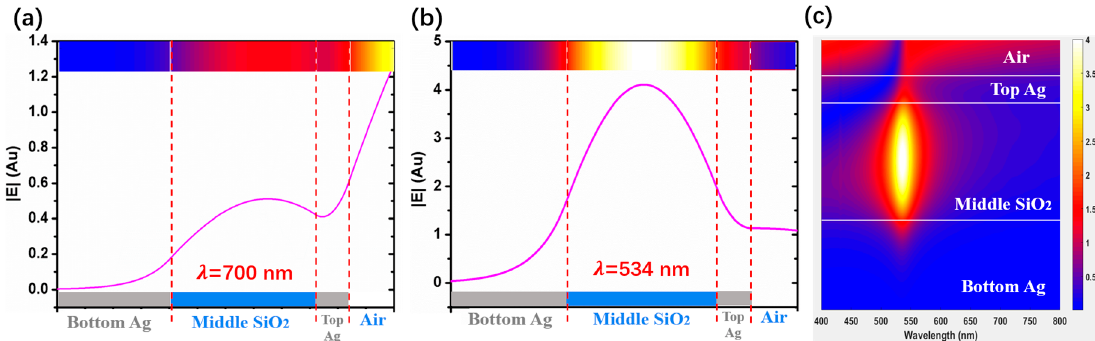
Figure 4. ( a , b ) Simulated E-field intensity distributions by the FDTD algorithm at the resonance wavelength of 534 nm and non-resonance wavelength of 700 nm, respectively. The three layers of the MDM absorber consist of a 30 nm top Ag layer, a 130 nm middle SiO 2 layer, and a 100 nm bottom Ag layer. ( c ) Simulated E-field distributions as a function of wavelength in the visible region.